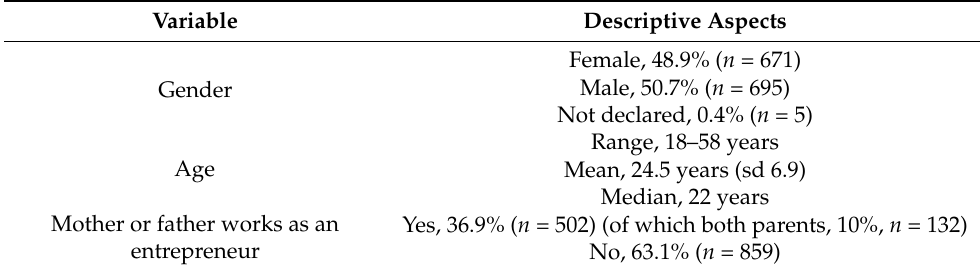
Table 1. Descriptive statistics of the